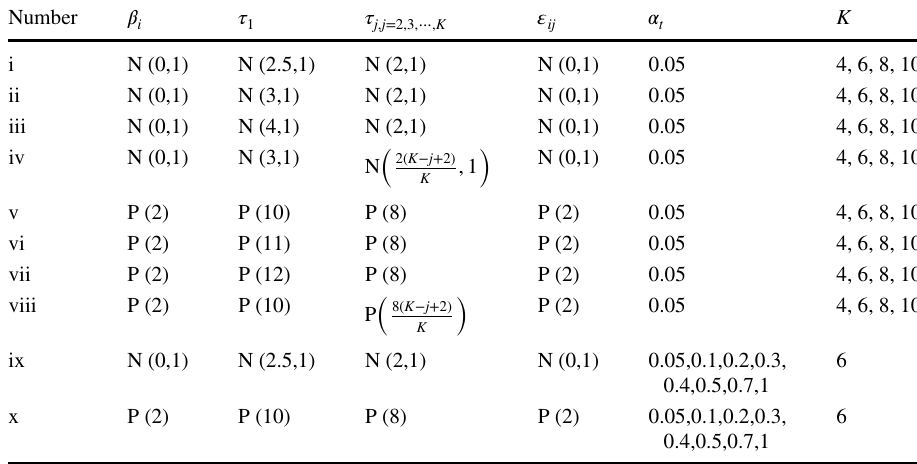
Table 3 Parameters setting of the